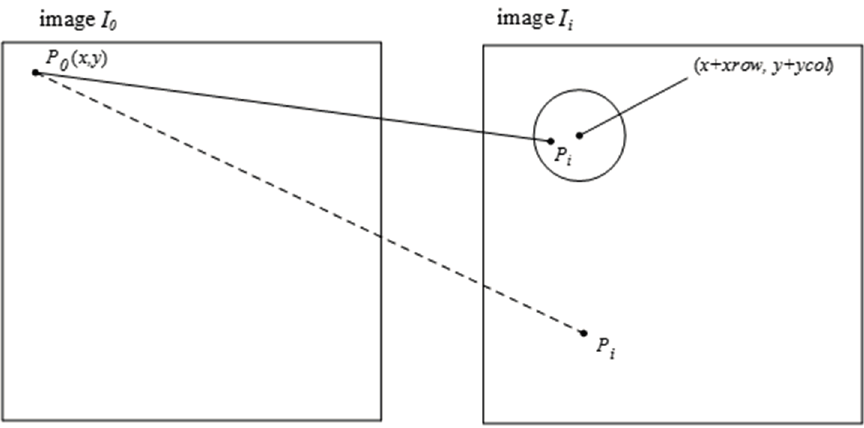
Figure 3. The dotted line shows a false match because p i is too far away from ( x + xrow , y + ycol ). And, the match showed by the solid line will be